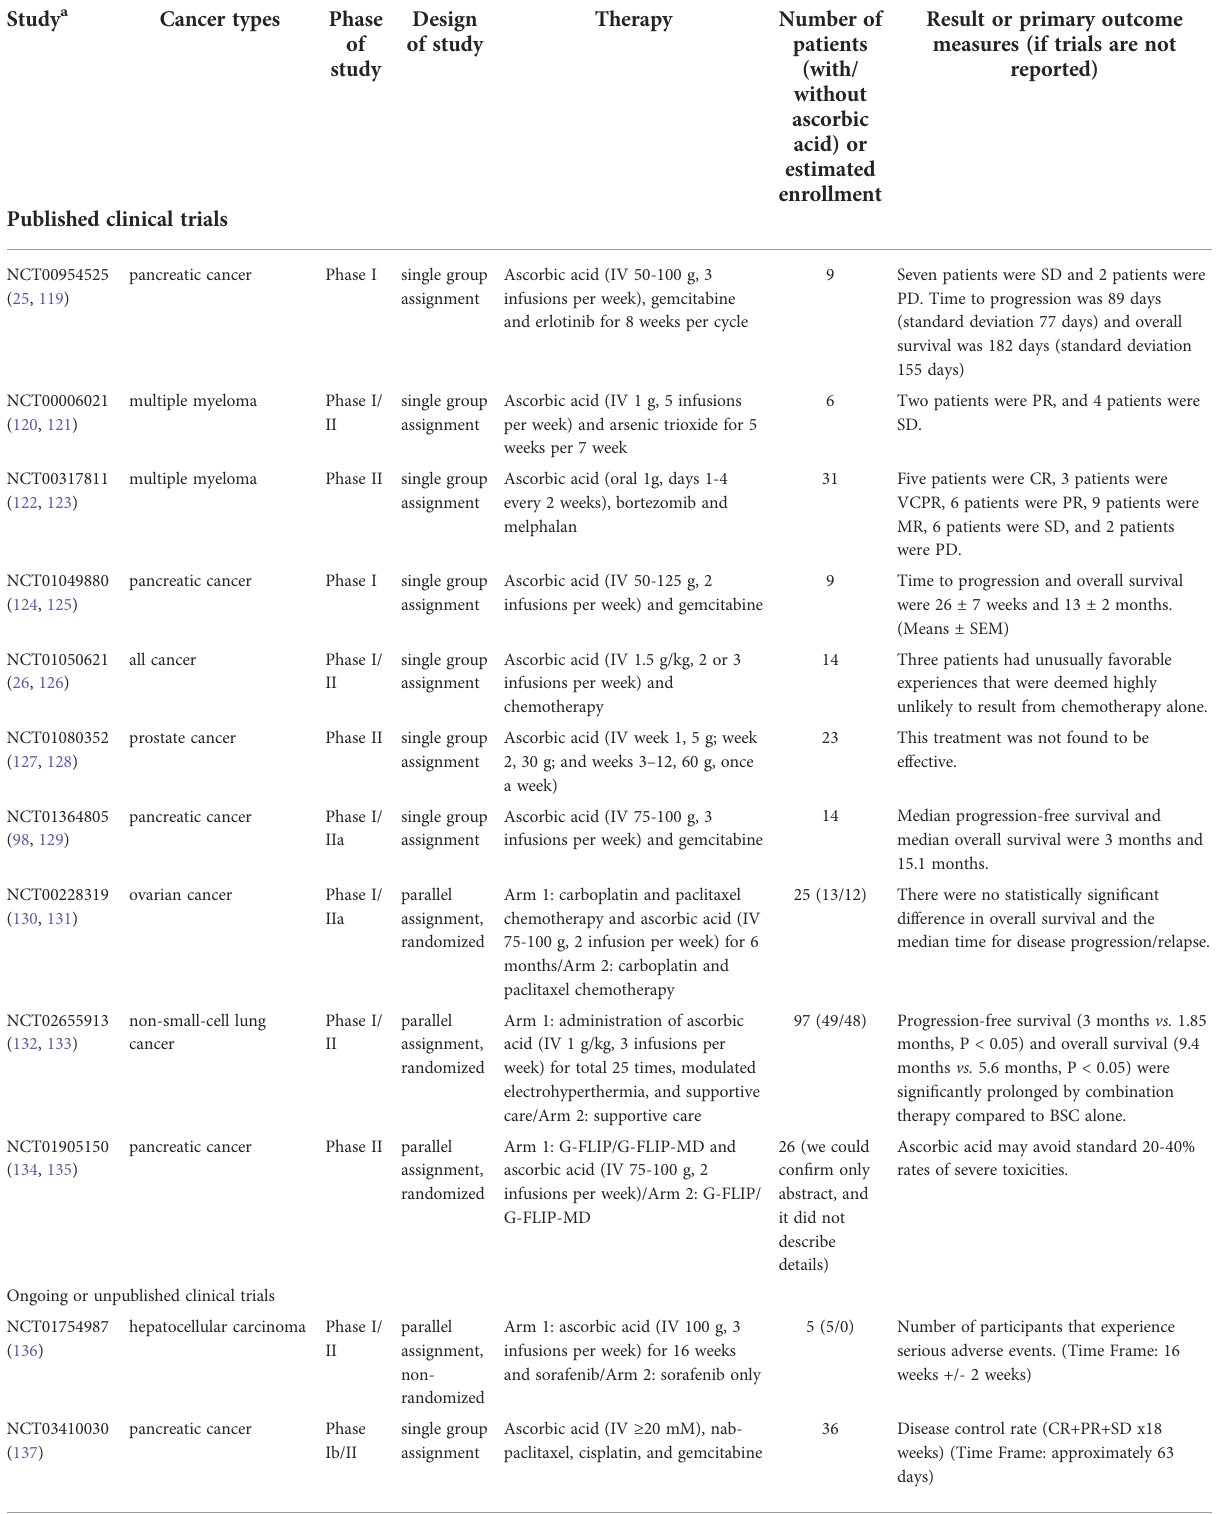
TABLE 2 Clinical trials on ClinicalTrials.